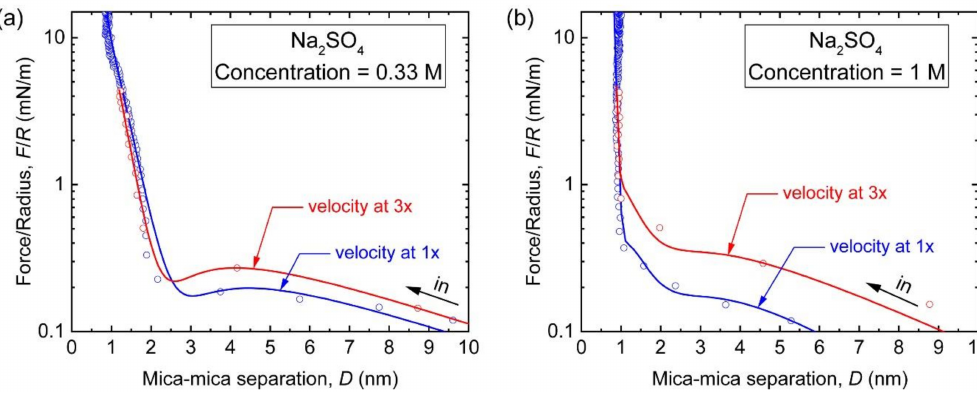
Figure 4. F / R vs. D profiles (semi-log plots) measured between two mica surfaces during approaching in the Na 2 SO 4 solutions. The concentrations of Na 2 SO 4 are ( a ) 0.33 M and ( b ) 1 M. The surfaces were driven at 1 × velocity (blue; motor speed = ~300 rpm) to 3 × velocity (red; motor speed = ~900